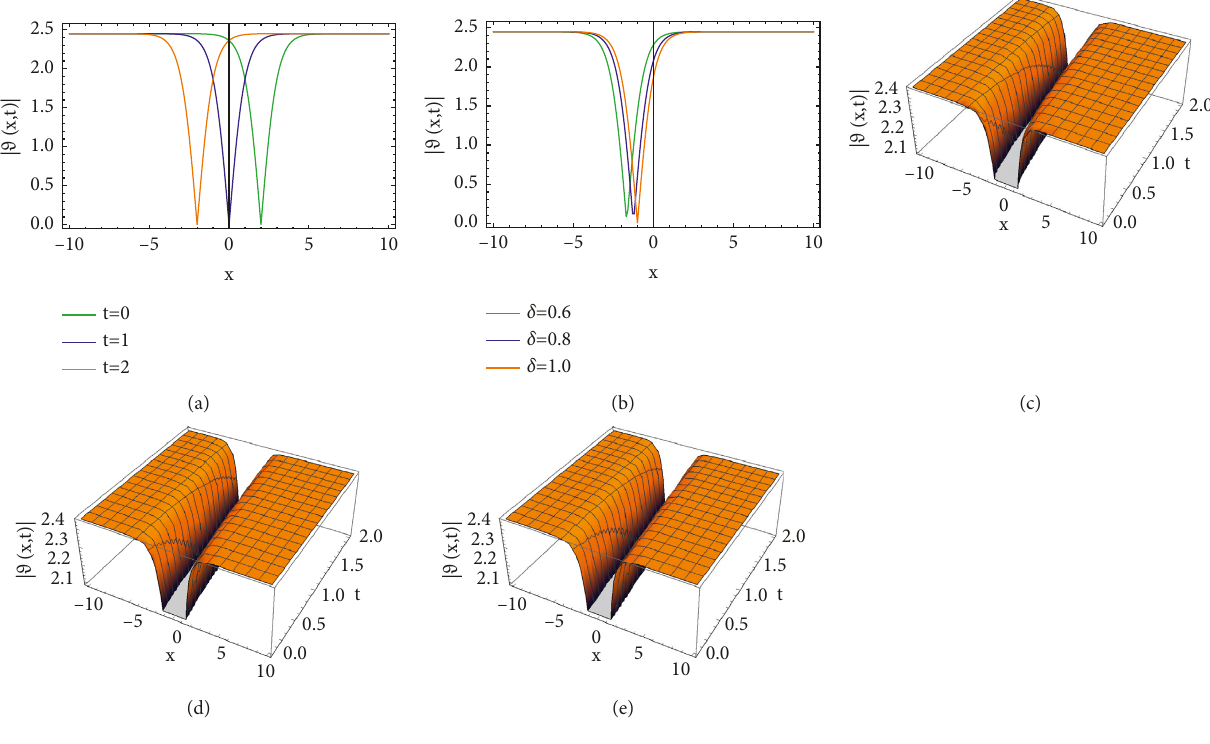
Figure 1: Solitary wave profile of ϑ